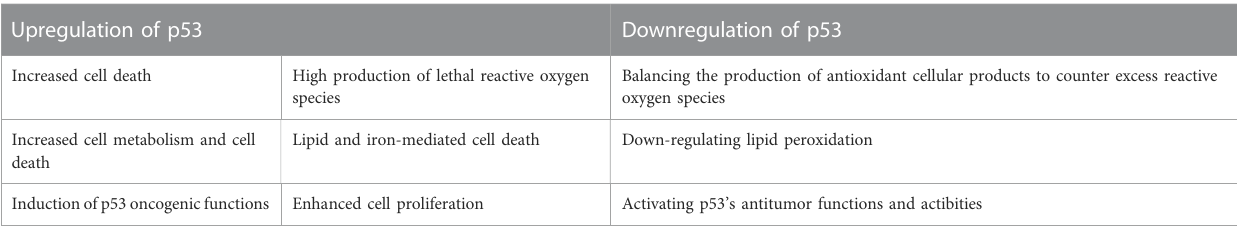
TABLE 4 A comparison of p53 ’ s up-and down-regulatory mechanisms in osteosarcoma-related ferroptosis. Upregulation of